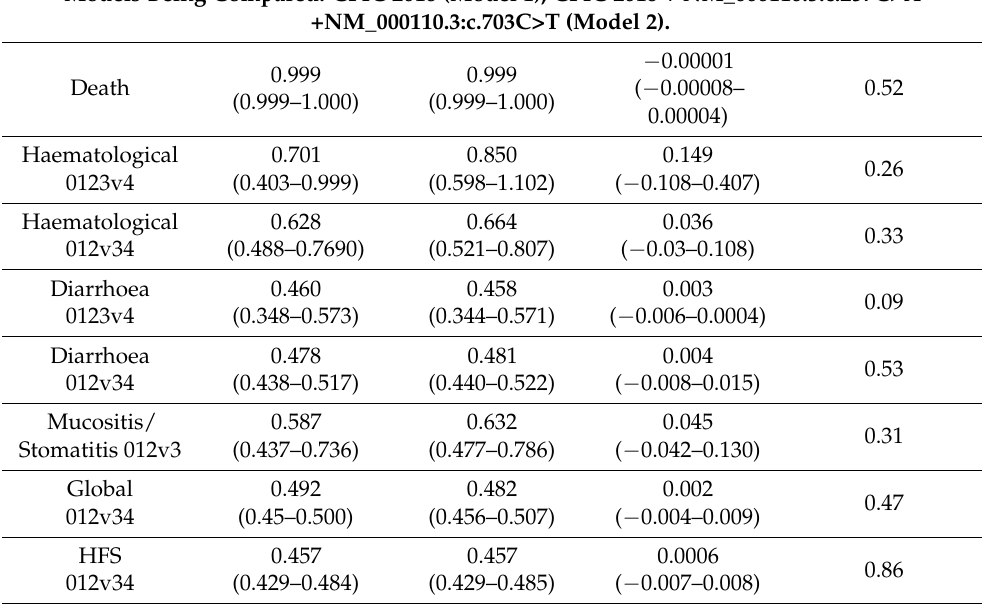
Table 1. AUC differences when a model containing the four variants with high evidence linking DPYD genotype to dihydropyrimidine dehydrogenase (DPD) phenotype and toxicity (model 1) was compared to a model containing these four variants and two additional DPYD deficiency alleles detected in QUASAR 2 (model 2). 845 samples were included in the analysis. Mode 1 Versus Model 1 AUC Model 2 AUC p Model 2 AUC Outcome Tested 95% CI 95%CI Difference Models Being Compared: CPIC 2018 (Model 1), CPIC 2018 + NM_000110.3:c.257C>A +NM_000110.3:c.703C>T (Model 2). Death